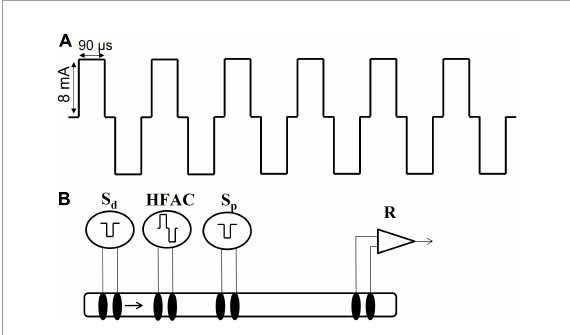
FIGURE3 High frequency alternating current waveform and electrode configuration for the isolated nerve electrophysiology studies. (A) The high frequency alternating current (HFAC) was a 5,000 Hz signal with 90 us square wave pulses with a 10 us shorting period between the charge and recharge phases and delivered at 8 mA. This HFAC signal was used in the isolated nerve electrophysiology experiments as well as the in vivo rat and swine experiments. (B) The electrode configuration used in the isolated vagus nerve electrophysiology experiments consisted of a distal stimulation electrode (S d ), an electrode delivering HFAC, a proximal control stimulation electrode (S p ) and a recording electrode (R). The segment of nerve between the proximal stimulation and the recording electrodes was submerged in oxygenated SIF. The proximal stimulation electrode was used to test for HFAC-induced excitation which may produce fatigue following cessation of the HFAC signal; as opposed to a prolonged depolarization block at the site of the HFAC